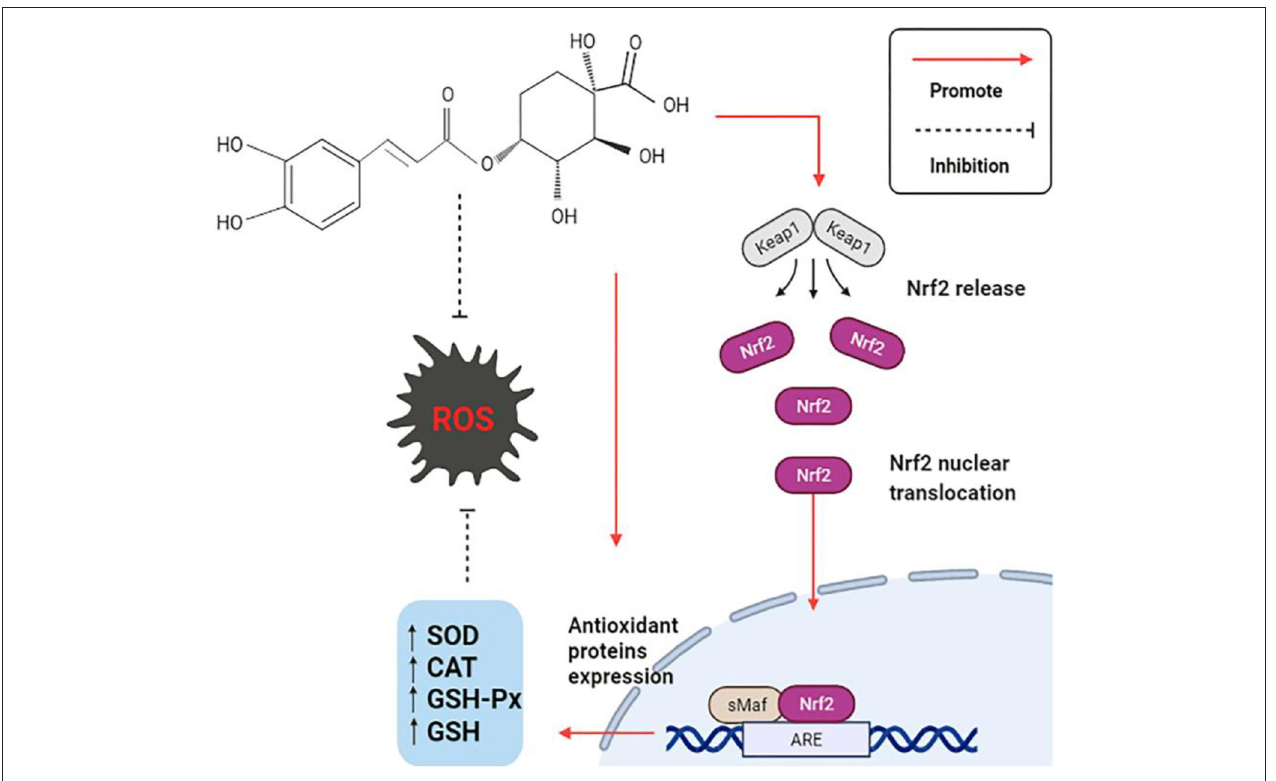
FIGURE 4 | Anti-oxidation mechanism of